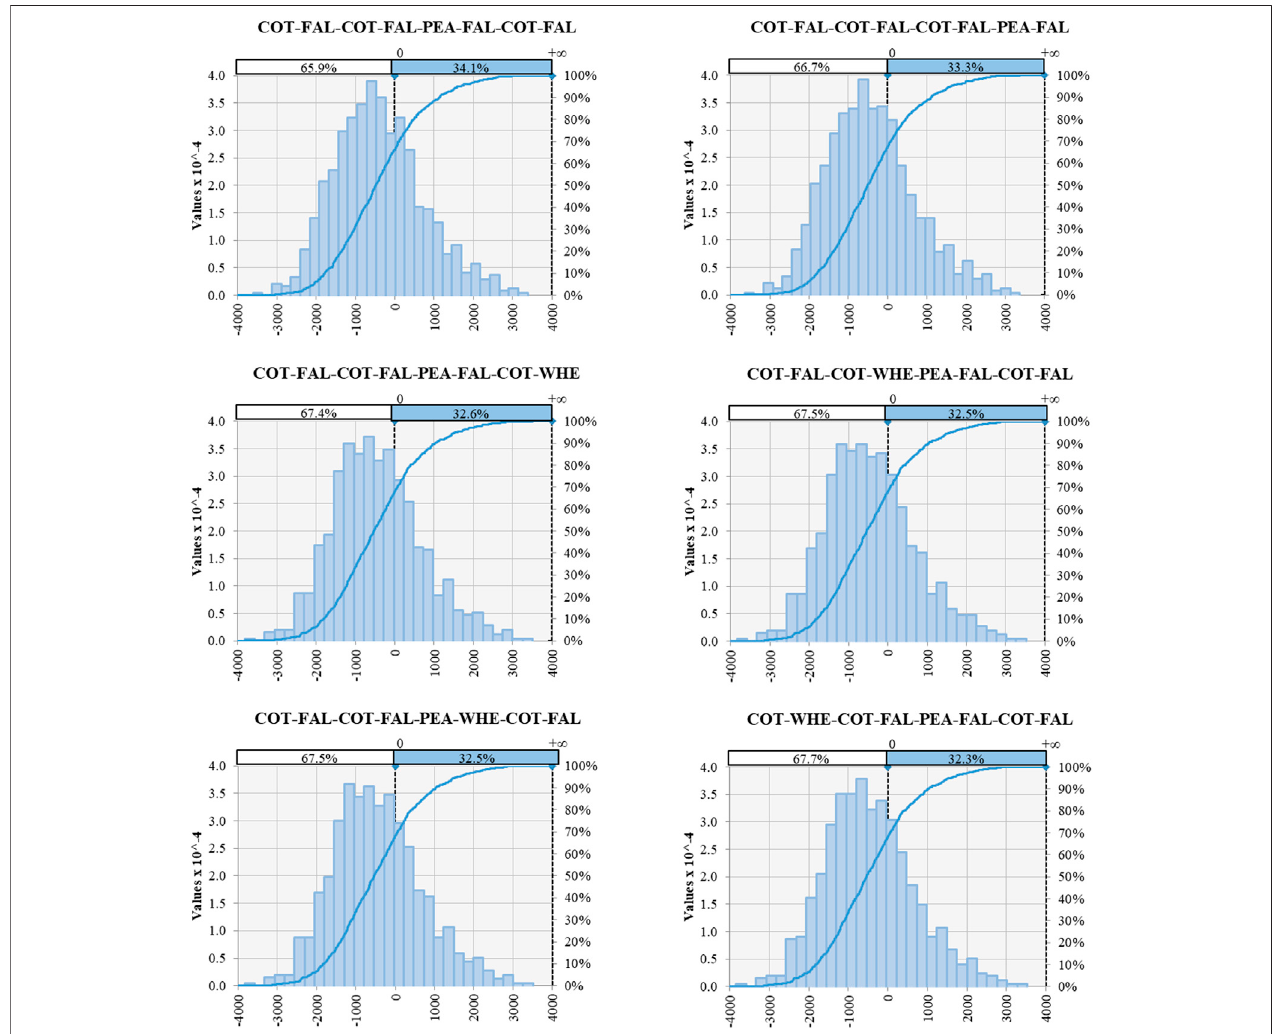
FIGURE 6 | Relative distribution and cumulative frequency of top-six rotations under S2 with the highest chance of positive NPVs.